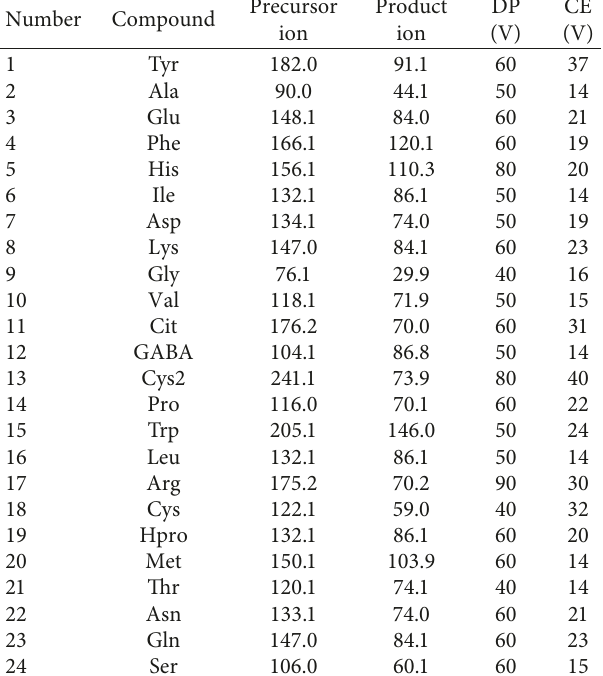
Table 2: The precursor ions, product ions, declustering potential, and collision energy of amino